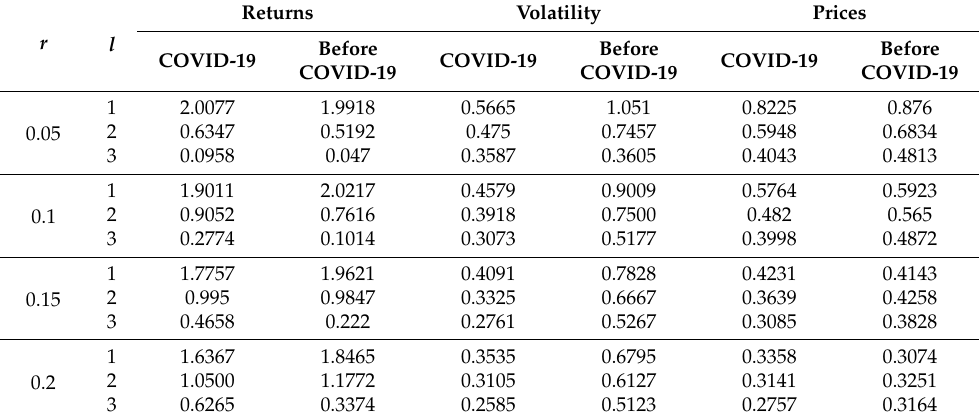
Table 6. Estimates of the approximate entropy for estimated volatility, closing prices, and closing returns of PSX-100.